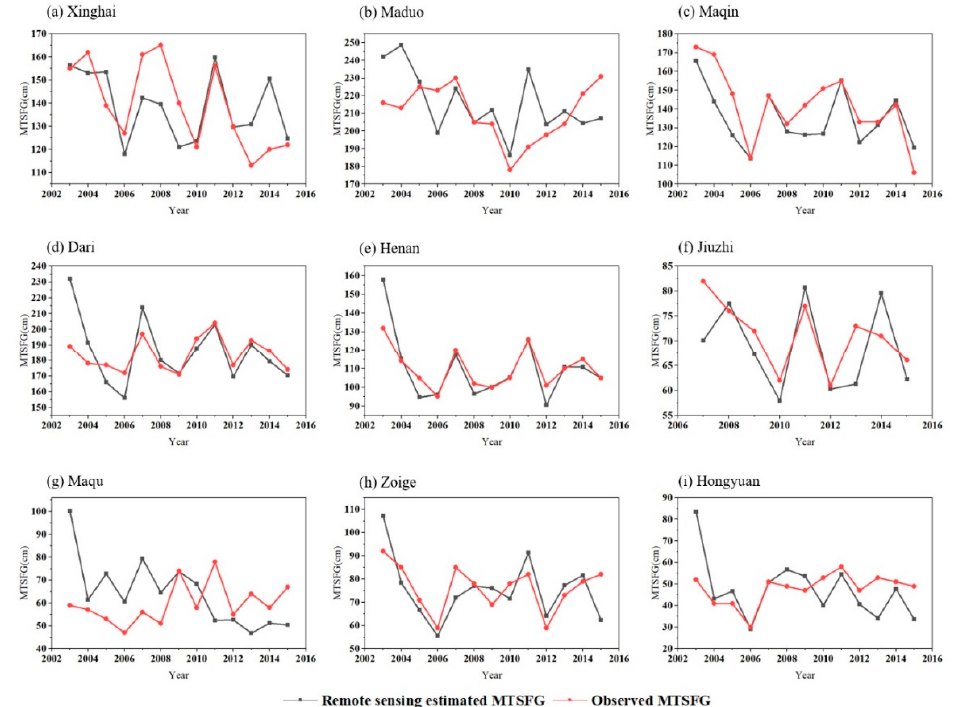
Figure 4. Comparison of the temporal variations of the observed and remote-sensing–estimated MTSFG at the: ( a ) Xinghai station, ( b ) Maduo station, ( c ) Maqin station, ( d ) Dari station, ( e ) Henan station, ( f ) Jiuzhi station, ( g ) Maqu station, ( h ) Zogie station, and ( i ) Hongyuan